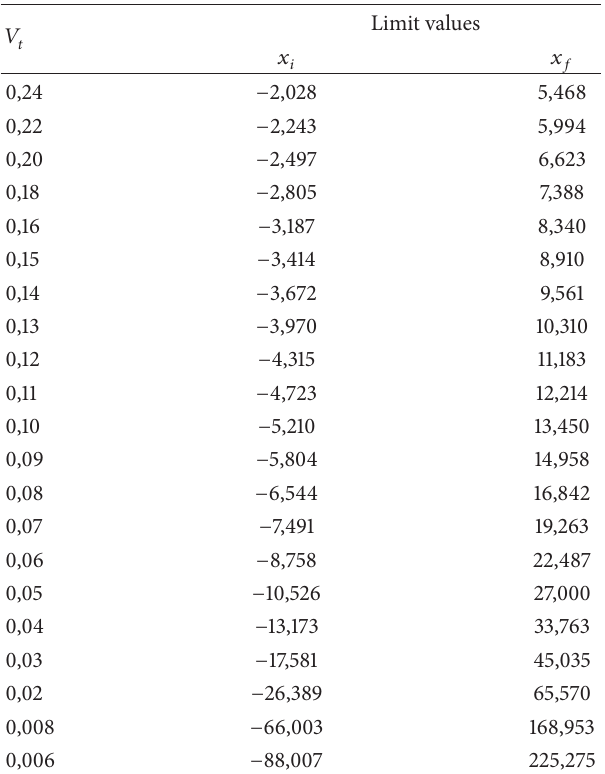
Table 1: Limit dimensionless values for the mesh of particles in the trapping region of a Rankine vortex as a function of 𝑉 𝑡